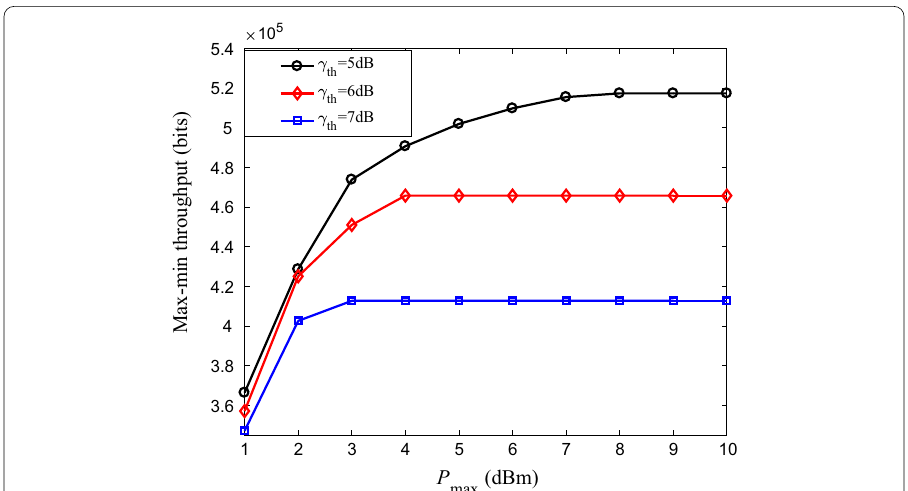
Fig. 4 Max–min throughput (bits) versus the optimal transmit power P max with different decoding threshold γ th of primary user